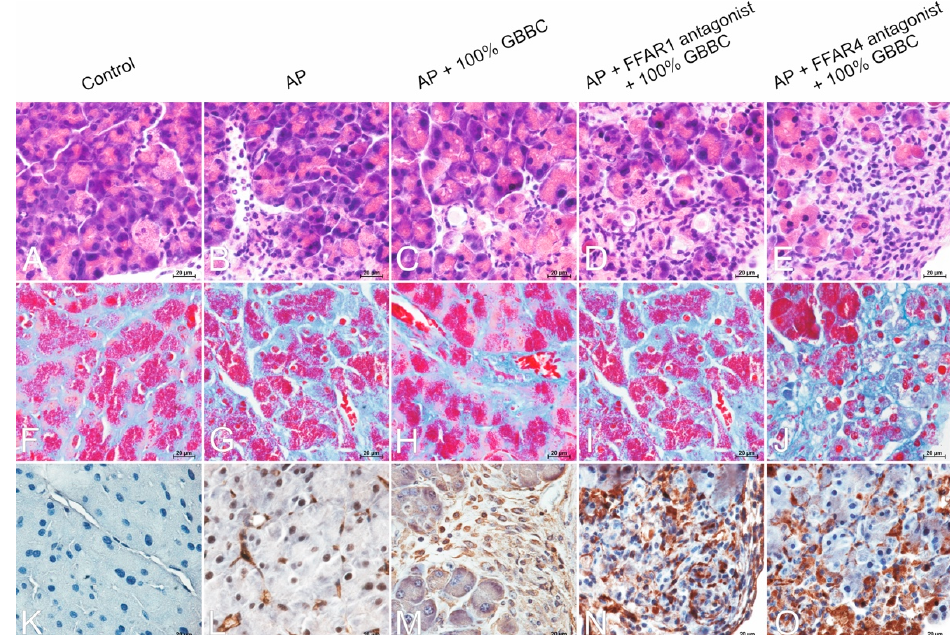
Figure 6. Microphotographs of the pancreas. H&E staining: control group—normal architecture of the exocrine pancreas with functional acinar cells rich in zymogen granules ( A ); acute pancreatitis (AP) group—diffuse inflammatory infiltrates in periacinar area with the predominance of neutrophils ( B ); AP + 100% ghee butter from bovine colostrum (GBBC) group—acinar cell vacuolization, minimal atrophy of acinar cells with no evidence of inflammatory cell infiltrates ( C ); AP + FFAR1 antagonist + 100% GBBC group—dissociation and moderate atrophy of acinar cells ( D ); AP + FFAR4 antagonist + 100% GBBC group—dissociation of acinar cells, strong remodeling of the stroma, and marked atrophy of acinar cells ( E ). Masson’s trichrome staining: control group—minimal collagen deposition as a delicate framework for acinar cells ( F ); AP group—minimal collagen deposition in inflamed and edematous stroma ( G ); AP + 100% GBBC group—minimal collagen deposition between well-compacted acinar cells ( H ); AP + FFAR1 antagonist + 100% GBBC group—moderate collagen deposition in periacinar area and between individual acinar cells ( I ); AP + FFAR4 antagonist + 100% GBBC group—marked deposition of collagen between atrophied acinar cells ( J ). Immunoreactivity of α -SMA protein: control group—negative reaction ( K ); AP group—positive reaction in individual myofibroblast-like cells ( L ); AP + 100% GBBC group—moderate positive cytoplasmic reaction in migrating myofibroblast-like spindle-shaped cells penetrating periacinar spaces ( M ); AP + FFAR1 antagonist + 100% GBBC group—strong immunohistochemical reaction in myofibroblast-like cells ( N ); AP + FFAR4 antagonist + 100% GBBC group—strong immunohistochemical reaction in numer- ous myofibroblast-like cells ( O ). Nikon’s Eclipse E600 light microscope (Nikon Instruments Inc., Tokyo, Japan) was used to examine tissue samples. Microphotographs were taken with a digital imaging system that included a microscopy digital camera (Nikon DS-Fil, Nikon Instruments Inc., Tokyo, Japan) and image analysis software (NIS-Elements BR-2.20, Laboratory Imaging, Praha,